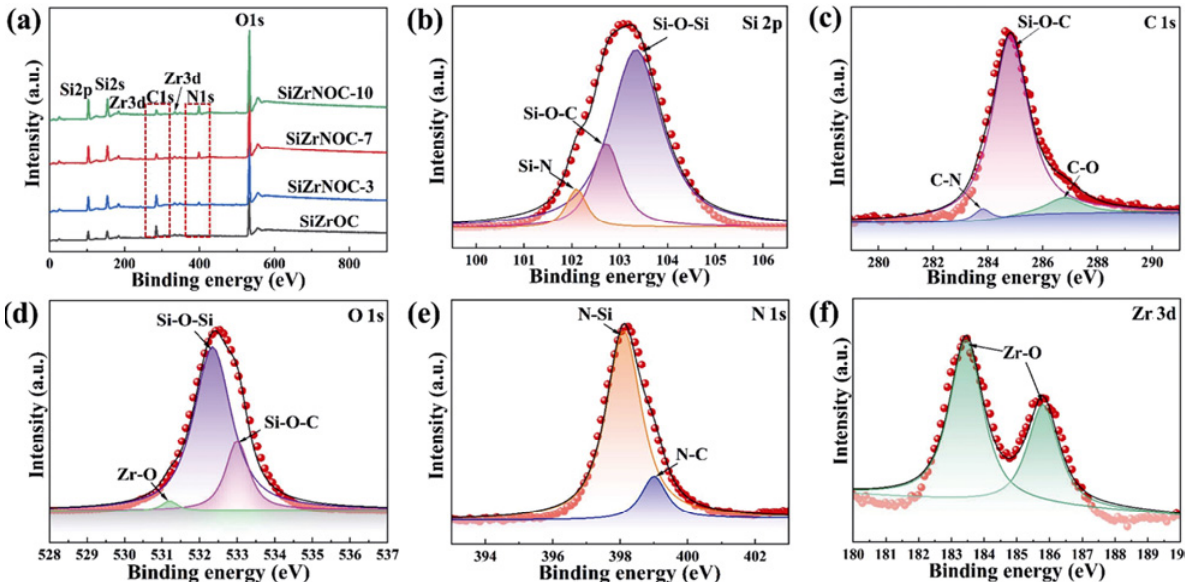
Fig. 3 (a) XPS survey spectra of SiZrNOC NFMs; fitting peaks of (b) Si 2p, (c) C 1s, (d) O 1s, (e) N 1s, and (f) Zr